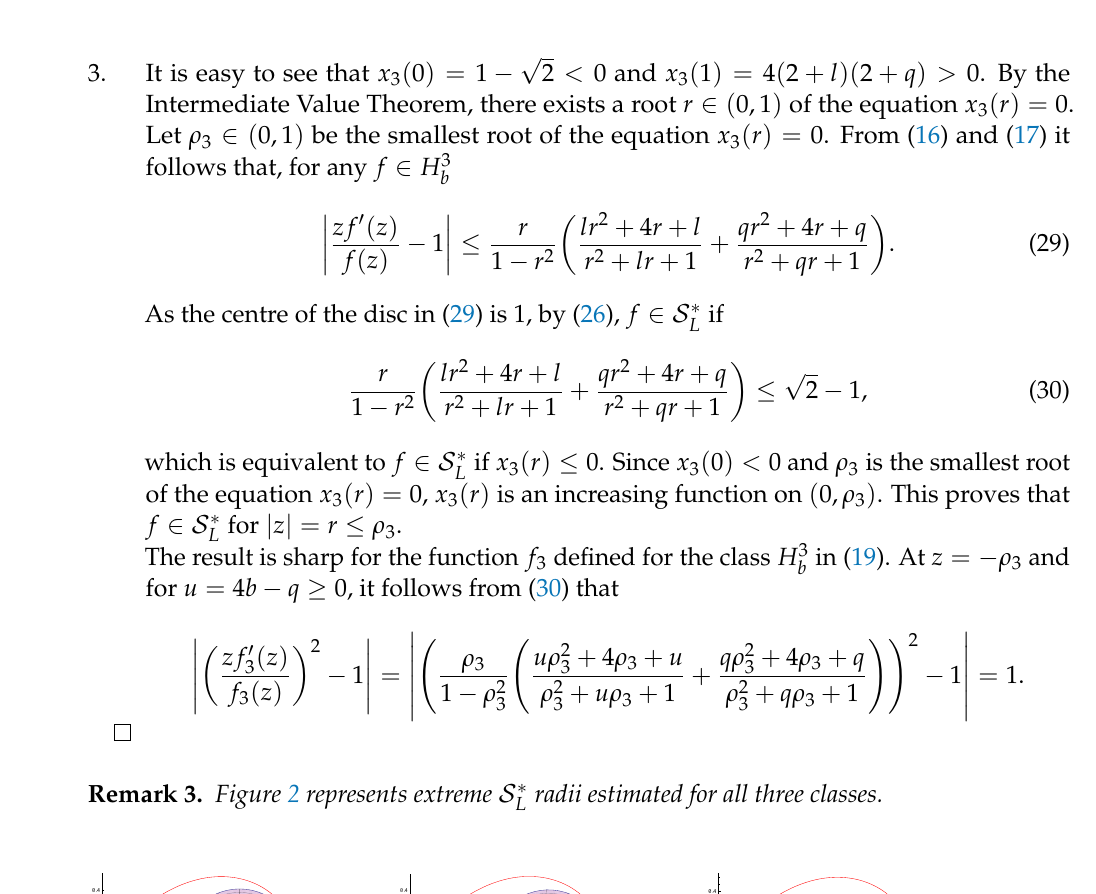
( H 1 ) , R S ∗ ( H 2 ) and R S ∗ 1,1 1,1 L L